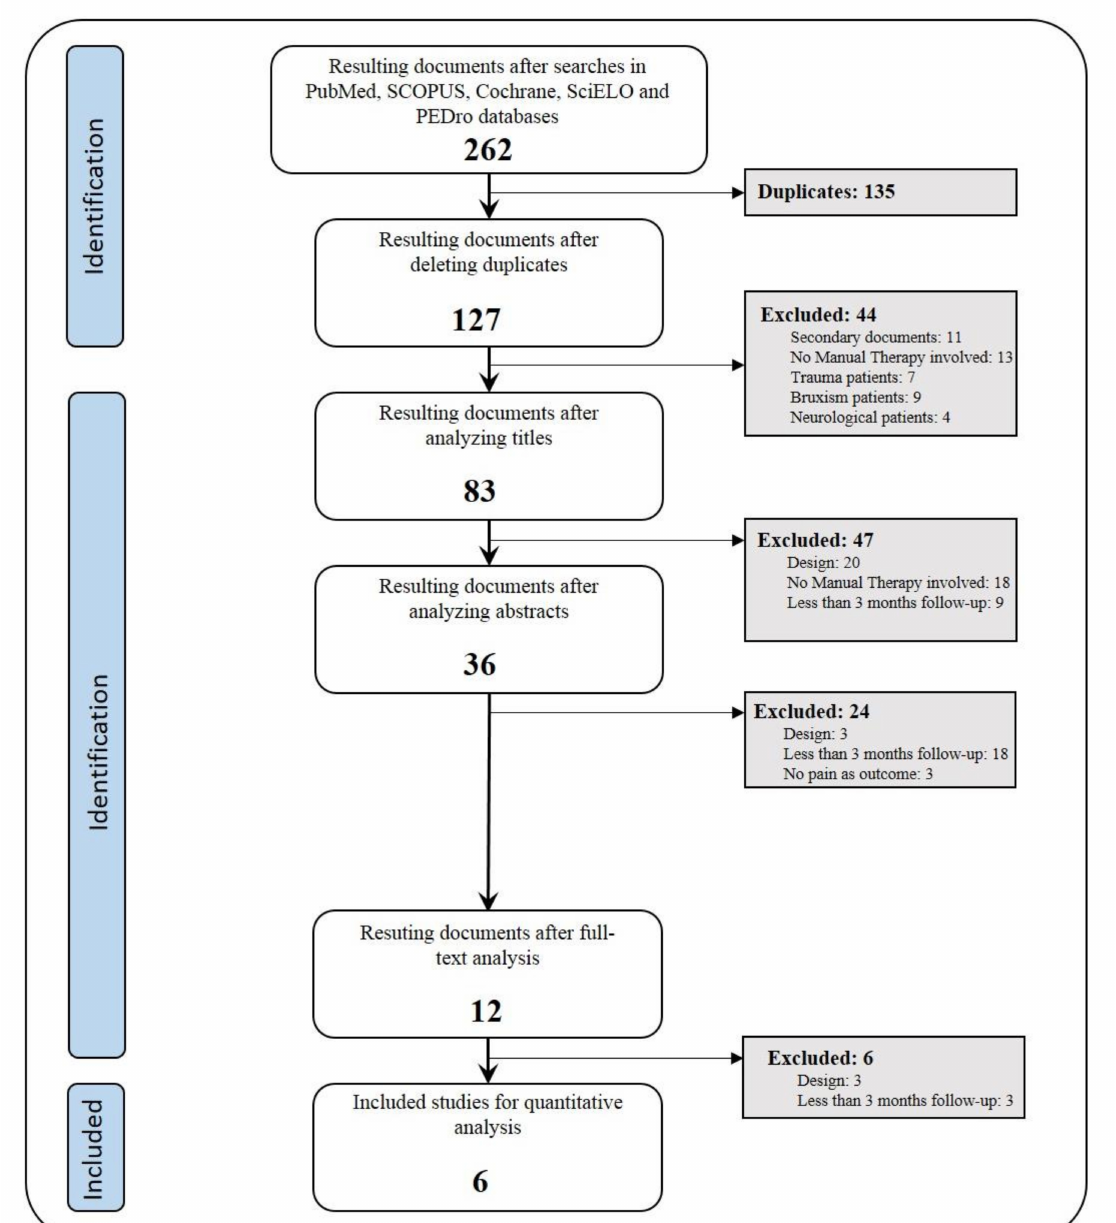
Figure 1. Search flow chart and documents